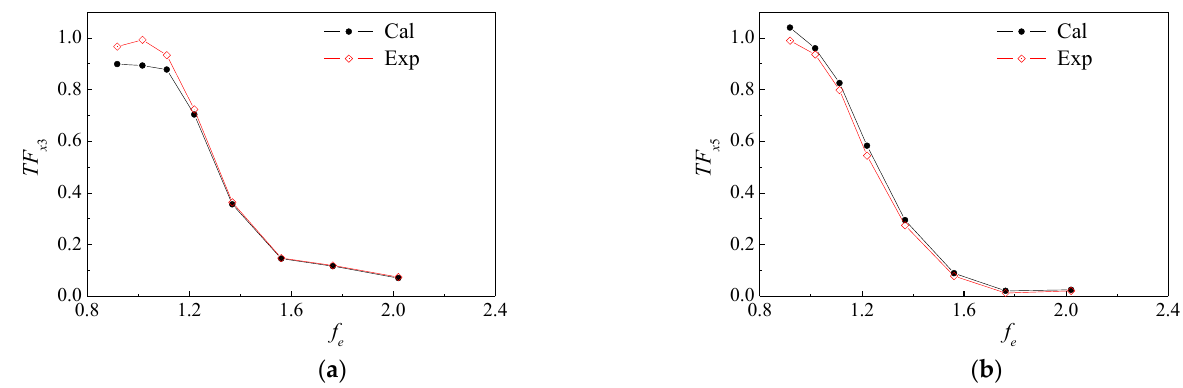
Figure 6. Comparison of numerical and experimental results of heave and pitch motion transfer functions 𝑇𝐹 𝑥3 and 𝑇𝐹 𝑥5 for different encounter frequencies 𝑓 𝑒 . ( a ) 𝑇𝐹 𝑥3 . ( b ) 𝑇𝐹 𝑥5 .